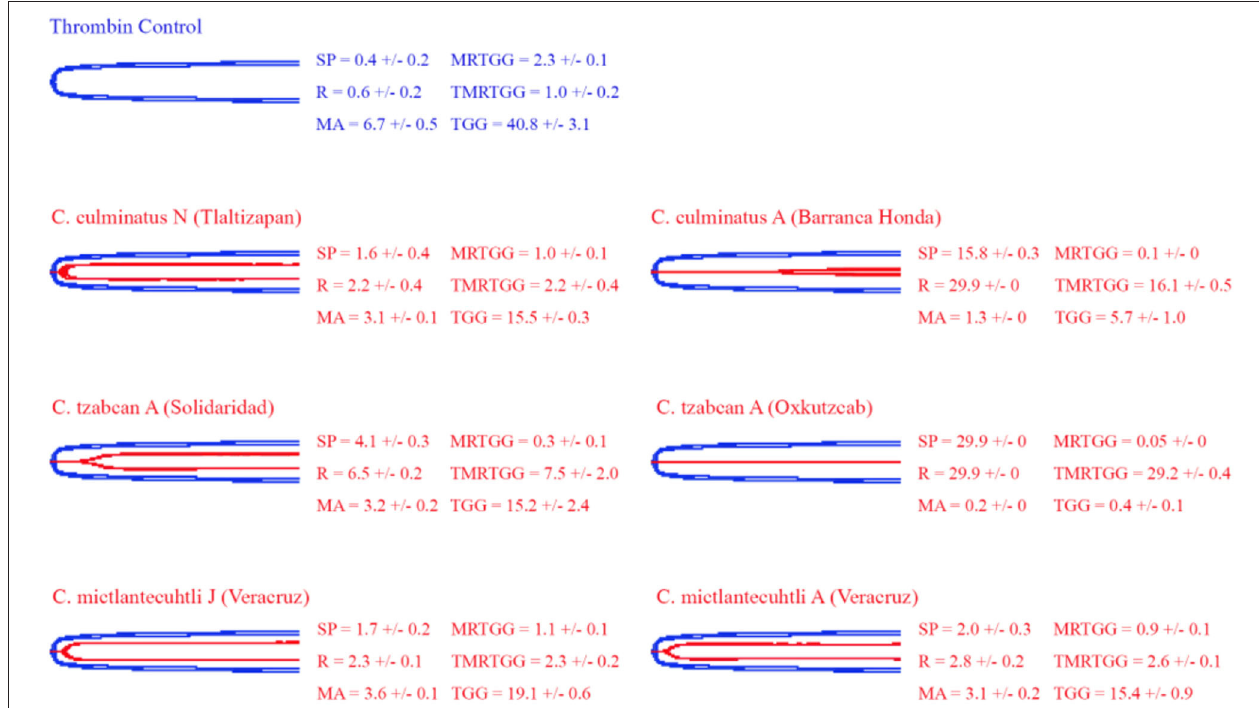
FIGURE 6 | Thromboelastography traces showing the coagulation pattern of human fibrinogen incubated with venoms of six Neotropical rattlesnake respresentatives for neonates (N), juveniles (J), and adults (A). Venom traces are shown in red, thrombin control traces in blue. SP, split point (min); R, time (min) to minimum detectable clot (2mm); MA, maximum amplitude (mm); MRTGG, maximum rate of thrombus generation (dynes/cm 2 ); TMRTGG, time to maximum thrombus generation (min); TGG, total thrombus generation (dynes/cm 2 ). Results shown as n = 4 mean ± SD.